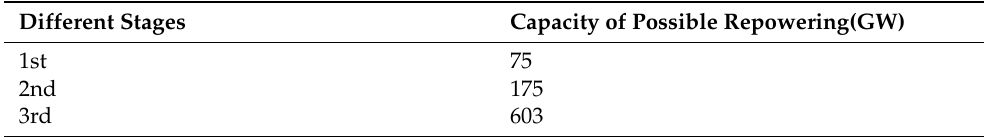
Table 5. Capacity of possible repowering in